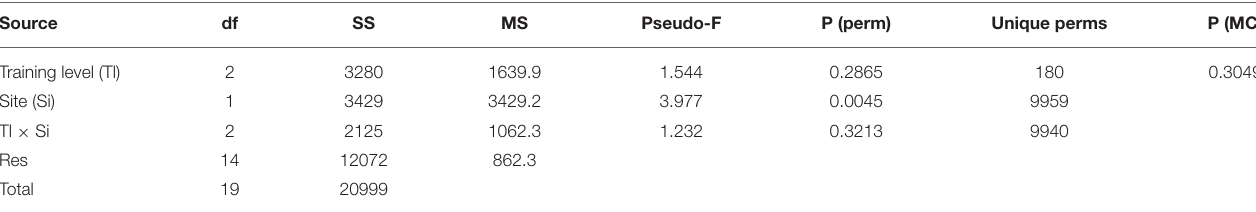
TABLE 4 | Permutational non-parametric multivariate ANOVA (PERMANOVA) test on differences among training levels (Tl, 3 levels, fixed) and between sites (Si, 2 levels, fixed) and their interactions (Tl × Si) (Bray–Curtis similarities abundance data).